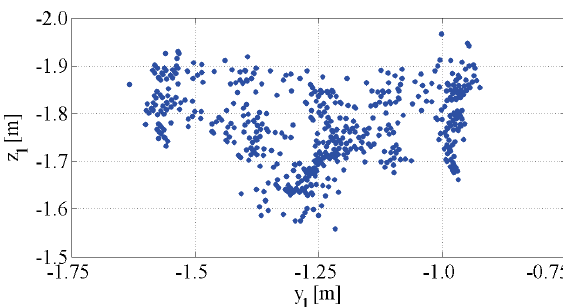
Figure 12: Magnified section of laser scanner plane during the test flight